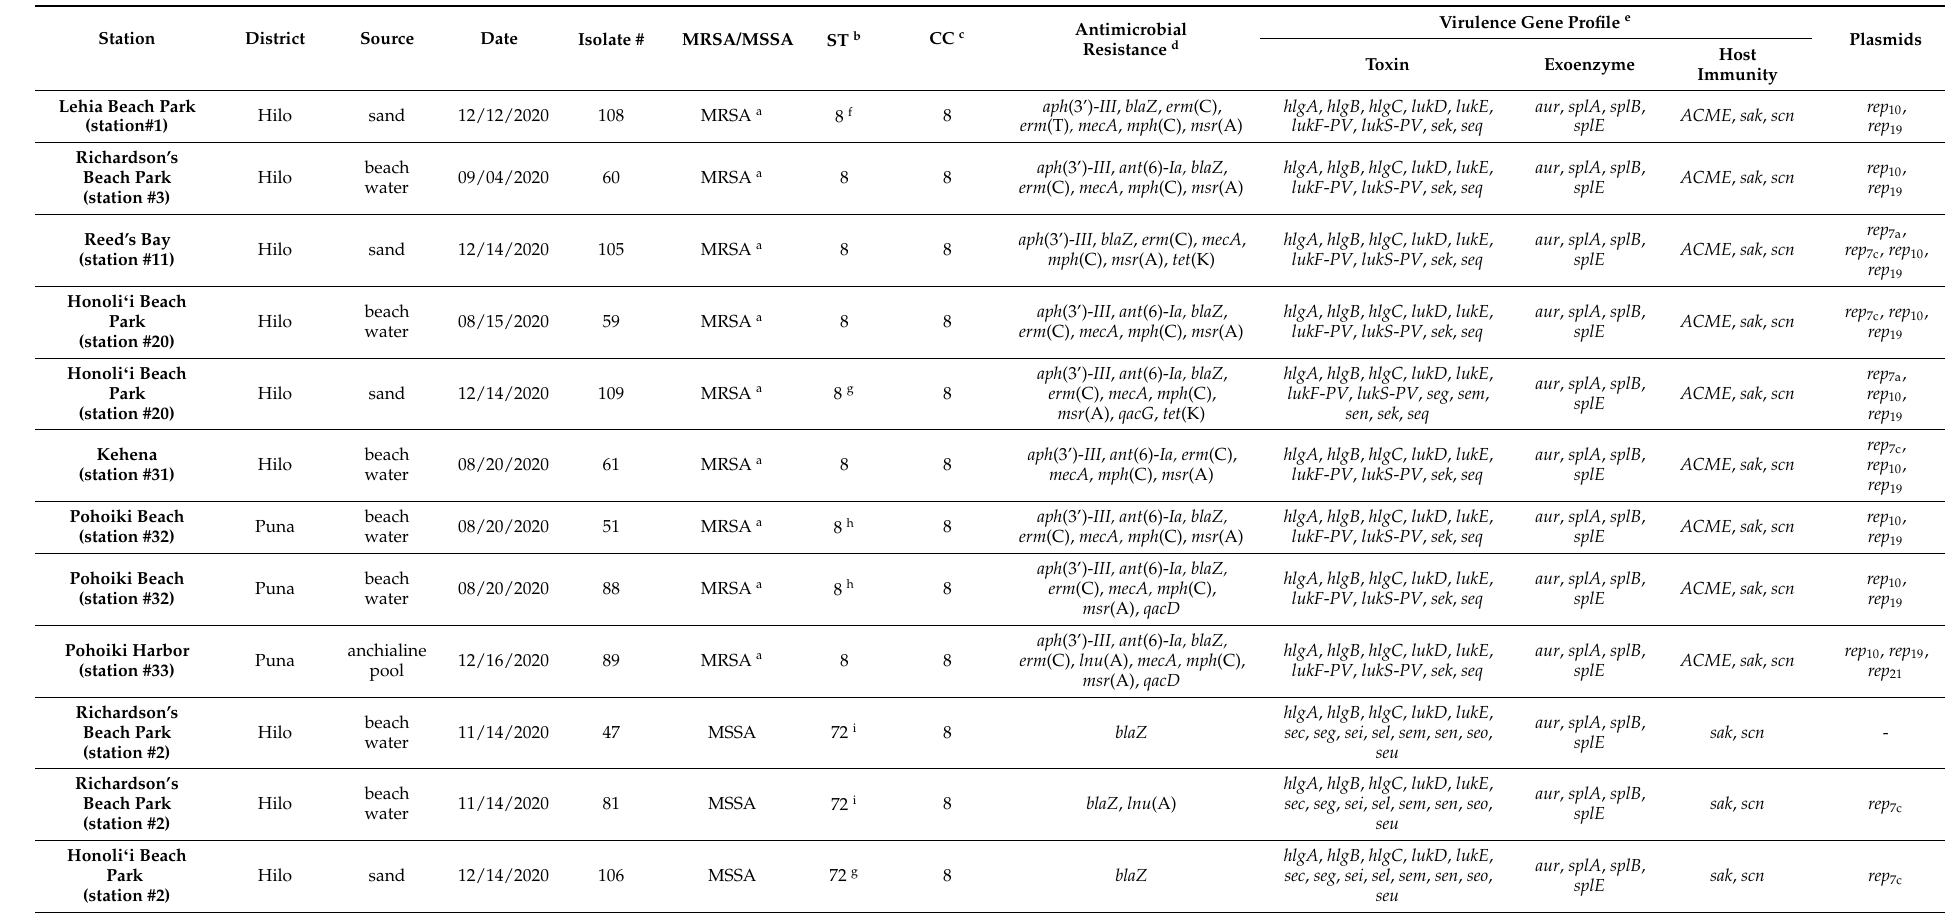
Table 2. Genomic characterization of MRSA (n = 9) and MSSA (n = 27) isolates collected from coastal beach and river waters, anchialine pools, and beach sand from July–December 2020 in the districts of Hilo, N. Kona, and Puna on Hawai ‘ i Island, Hawai ‘